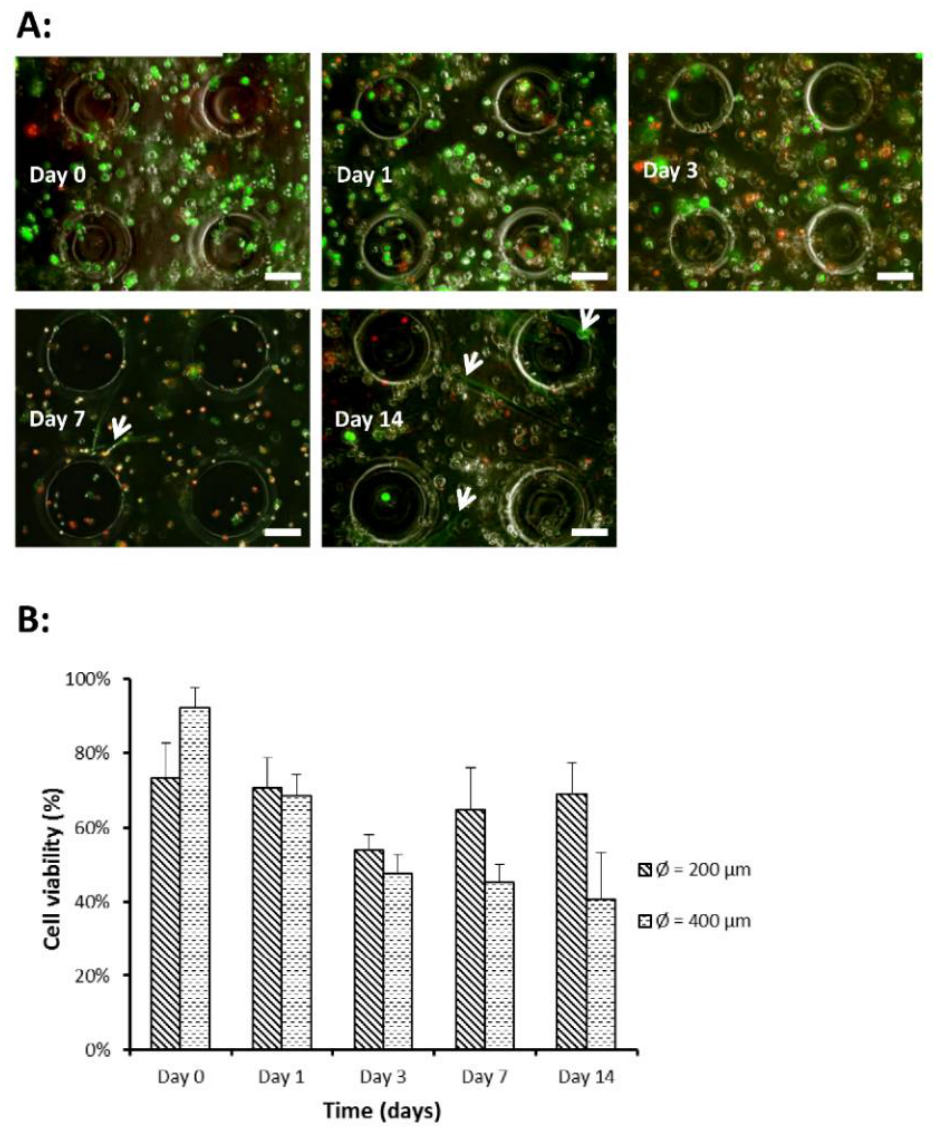
Figure 4. DPSC viability in hydrogel microwell array. ( A ) Merged fluorescence images of live/dead assay performed on encapsulated DPSCs (design 1: ø = 200 µ m). Green fluorescence indicates live cells while red fluorescence indicates dead cells. Cell spreading and exhibition of spindle-like morphology is seen on days 7 and 14 (indicated by white arrows). Scale bar = 100 µ m. ( B ) Percentage of DPSC viability over time. Cell viability was calculated by taking fluorescence intensity of live cells over total fluorescence intensity of live and dead cells. Each data point represents the mean ± SD ( n = 6).